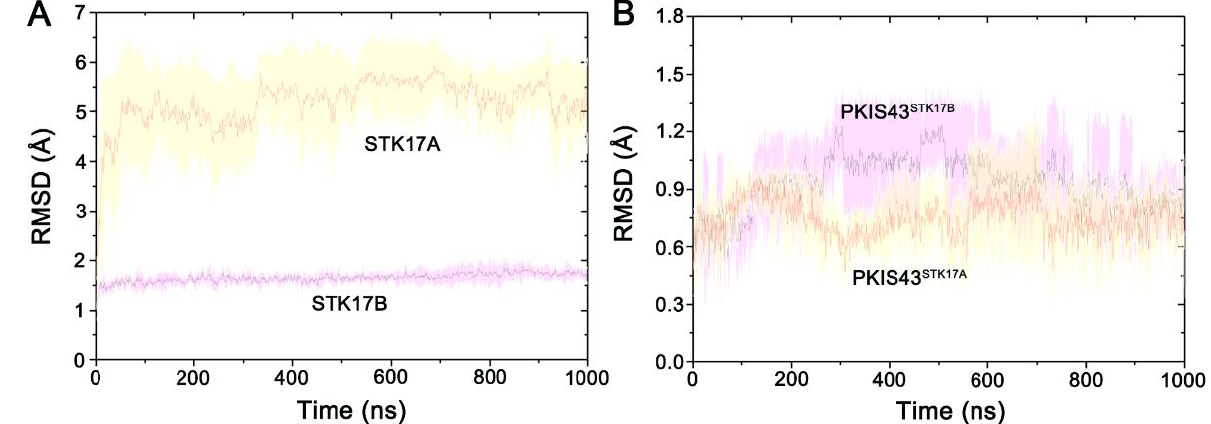
Figure 3. ( A ) The C α atoms of root-mean-square deviation (RMSD) for STK17B and STK17A averaged over four independent runs. ( B ) The heavy atoms of RMSD for PKIS43 in the ATP-binding site of STK17B and STK17A averaged over four independent runs. Transparent shade represents standard deviations.